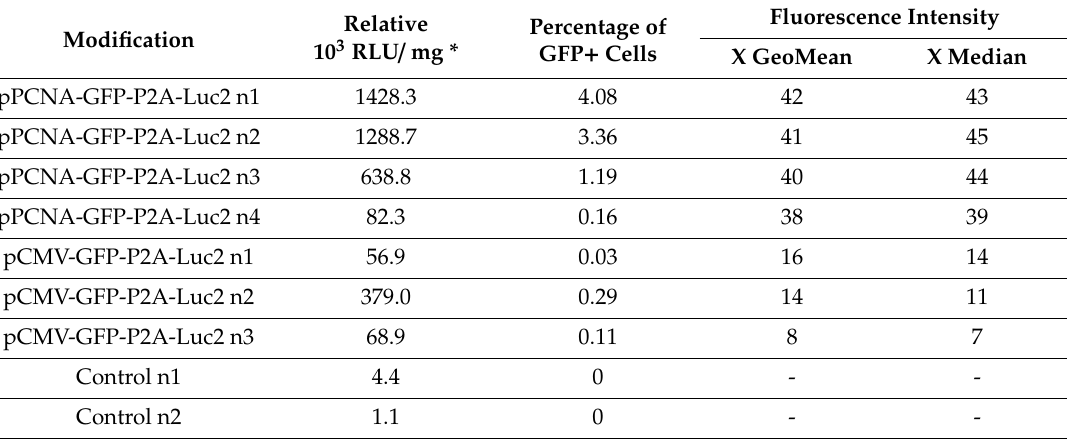
Table 2. Analysis of the GFP + cells content and luciferase activity in a suspension of tumor cells containing co-cultures of cancer line CT26.WT and various BALB / 3T3 fibroblasts. Fluorescence Intensity Relative Percentage of Modification 10 3 RLU / mg * GFP + Cells X GeoMean X Median pPCNA-GFP-P2A-Luc2 n1 1428.3 4.08 42 43 pPCNA-GFP-P2A-Luc2 n2 1288.7 3.36 41 45 pPCNA-GFP-P2A-Luc2 n3 638.8 1.19 40 44 pPCNA-GFP-P2A-Luc2 n4 82.3 0.16 38 39 pCMV-GFP-P2A-Luc2 n1 56.9 0.03 16 14 pCMV-GFP-P2A-Luc2 n2 379.0 0.29 14 11 pCMV-GFP-P2A-Luc2 n3 68.9 0.11 8 7 Control n1 4.4 0 - - Control n2 1.1 0 - - * Relative Light Units per milligram of